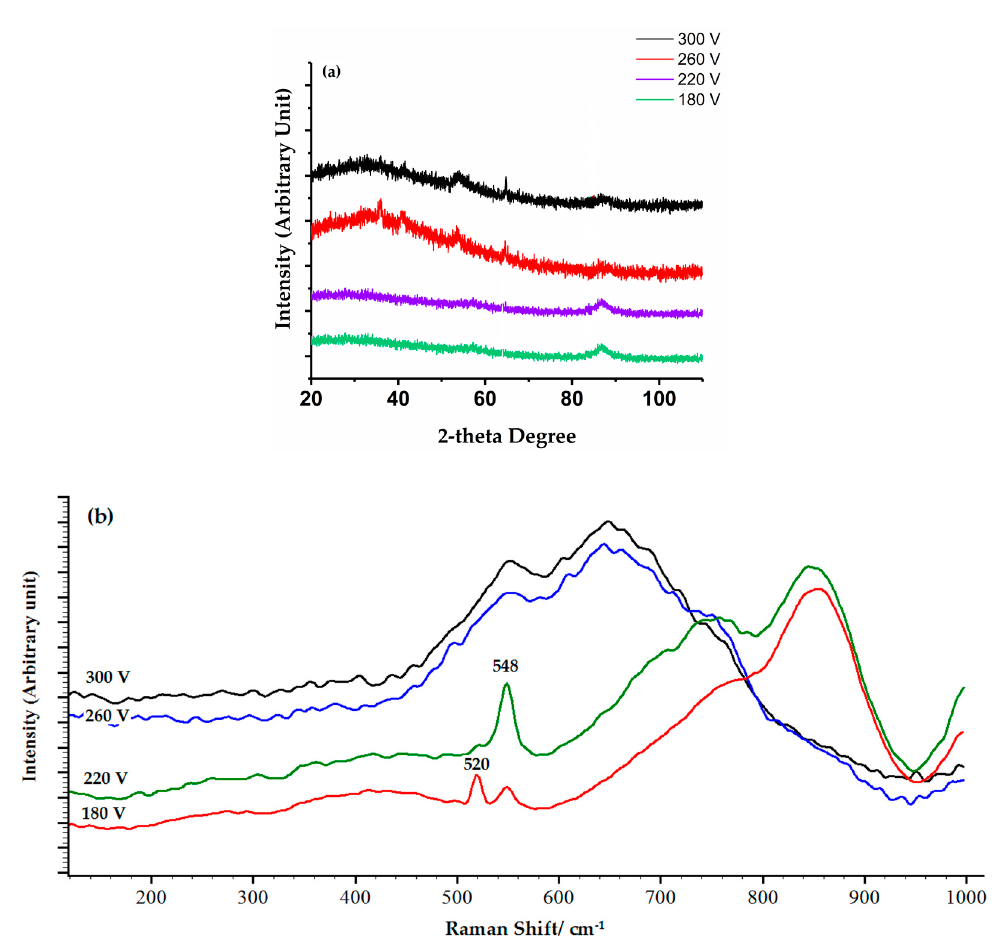
Figure 6. ( a ) XRD patterns and ( b ) Raman spectra of chromium oxide coatings deposited at different voltages.